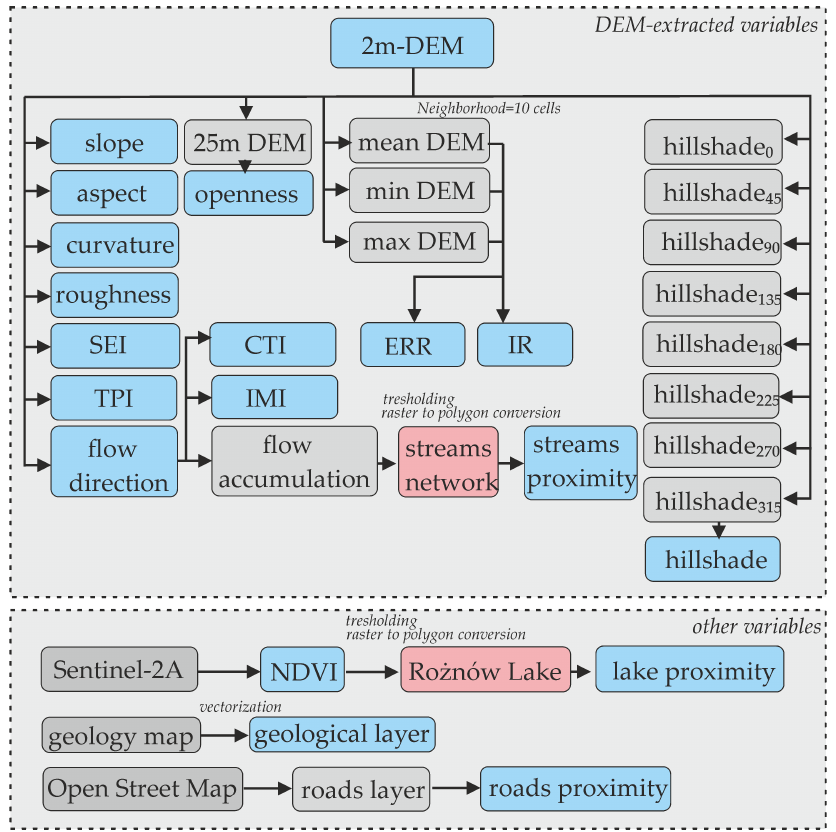
Figure 3. Interrelationships of the used variables. The subscripts by the variable “hillshade” indicate layers illuminated, in particular sun